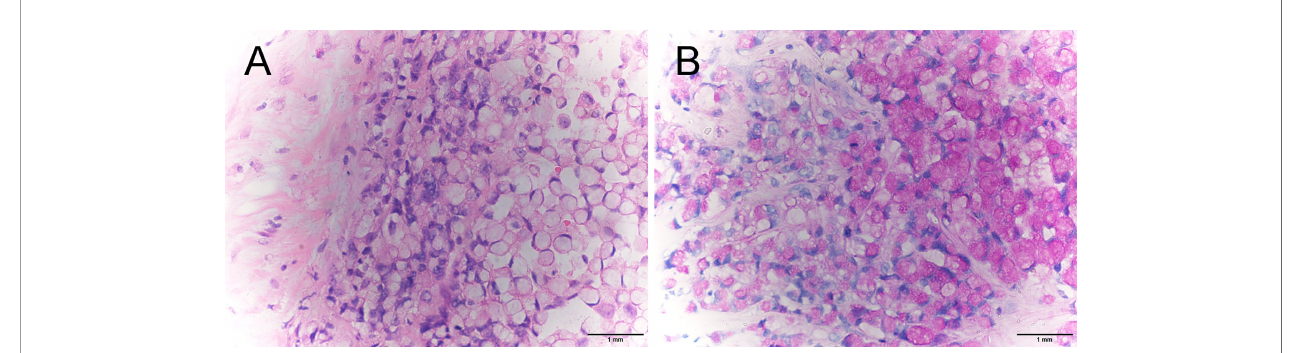
FIGURE 3 | Pathological examination of breast specimen revealed diffuse in fi ltration of signet-ring cells ( A , H&E stain, ×400) and intracytoplasmic lumens ( B , PAS